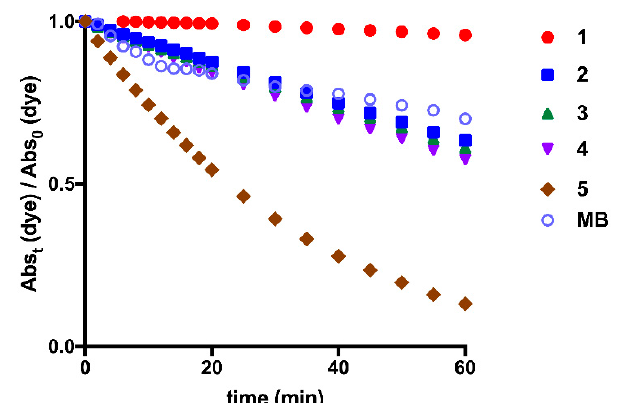
Figure 5. Photostability evaluation of dicyanomethylene squaraine dyes 1 – 5 and methylene blue ( MB ) in dimethyl sulfoxide (Abs t (dye)—absorbance of squaraine dye when irradiated at time t; Abs 0 (dye)—absorbance of squaraine dye without light-emitting diode irradiation).